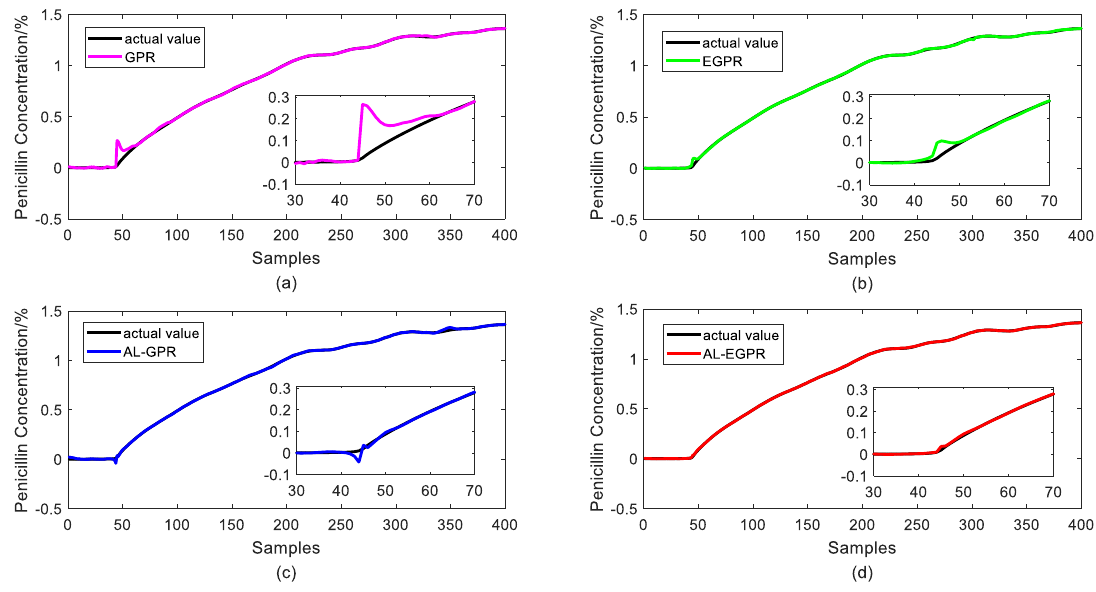
Figure 12. Prediction results of test samples for four different soft sensors after the 7 th iteration. (a) GPR model; (b) EGPR model; (c) AL-GPR model; and, (d) AL-EGPR model.